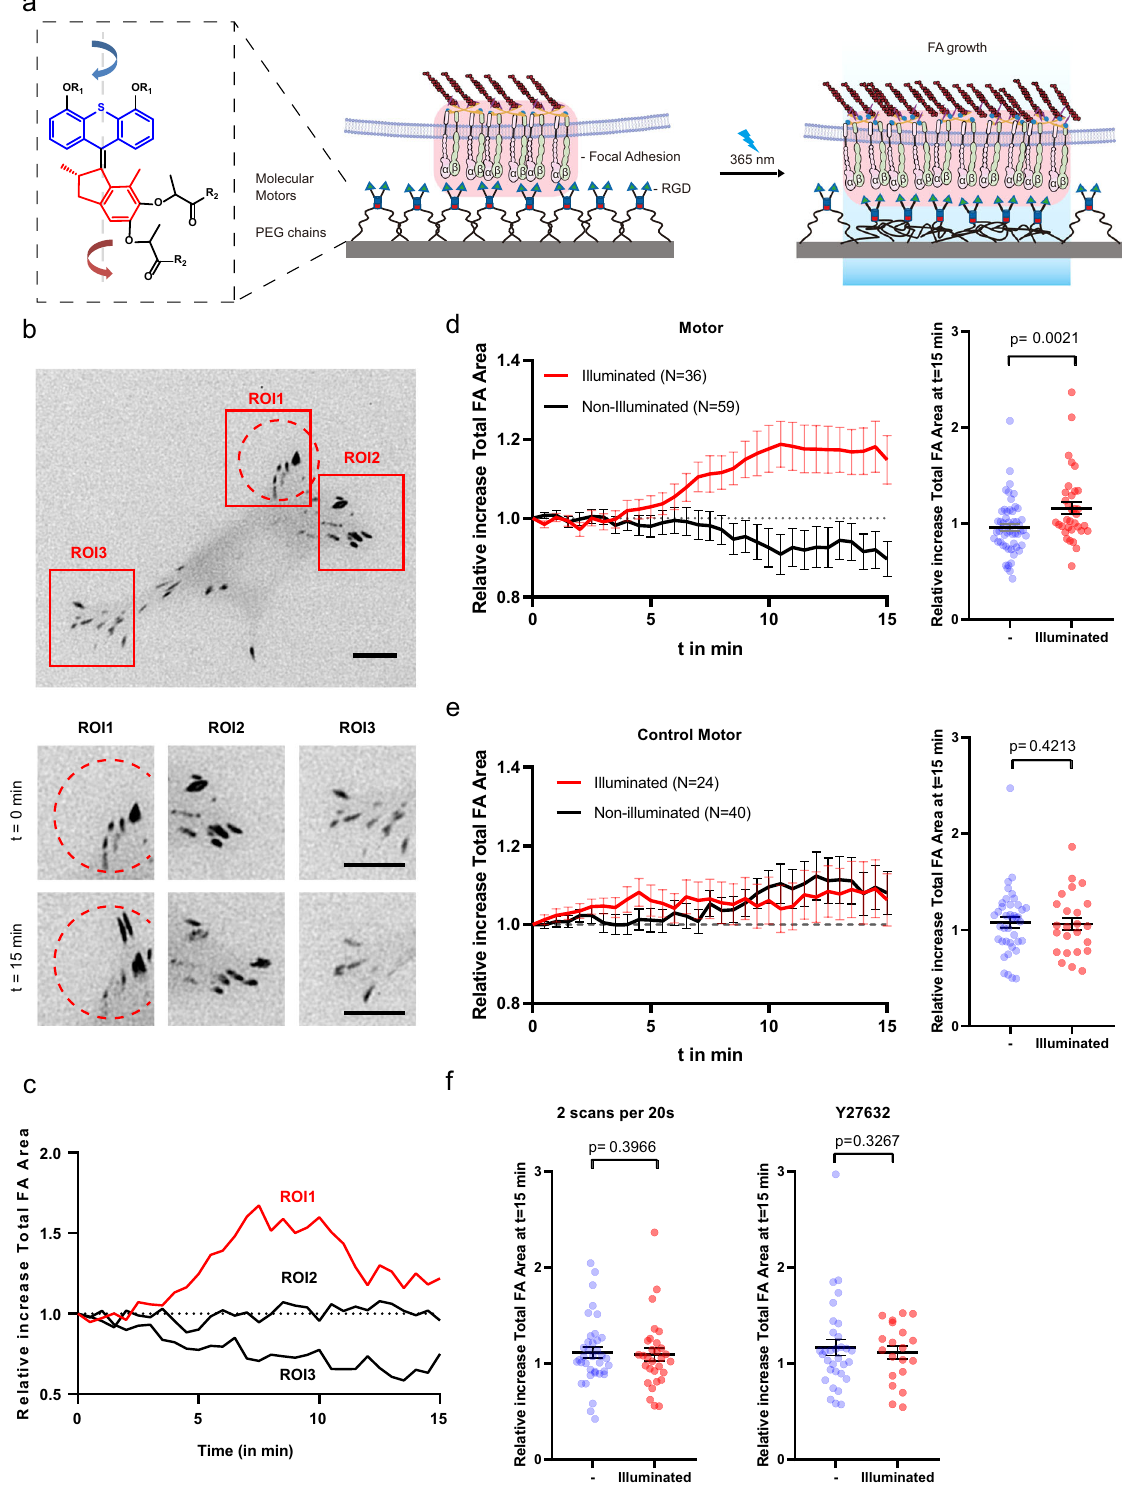
and non-illuminated areas (Fig. 1f and Supplementary Fig. 5a), indicating that this dose (and consequently force) was not enough to trigger a cellular response. Intermittent exposure programs (i.e., 3-min on, 3-min off, in 5 scans per 20 s) did not elicit any cellular response either (Supplementary Fig. 5b, c). In addition, by perturbing actomyosin contractility via ROCK inhibition with Y27632 (10 μM), the observed motor-induced increase of the FA